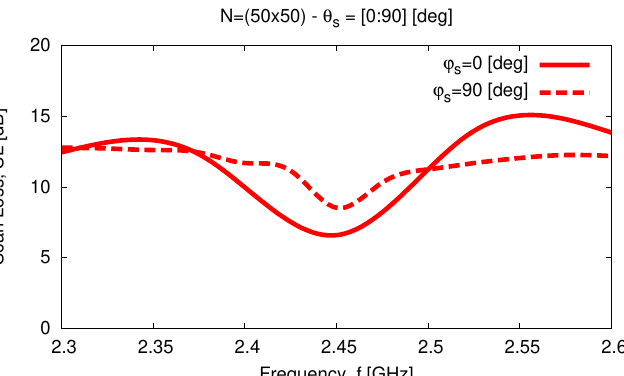
Figure 14. Numerical Assessment ( [ f min , f max ] = [ 2.3, 2.6 ] [GHz]— N = ( 50 × 50 ) )— SL performance versus frequency when steering the beam towards θ s ∈ [ 0, 90 ] [deg] and ϕ s = 0 [deg] or ϕ s = 90